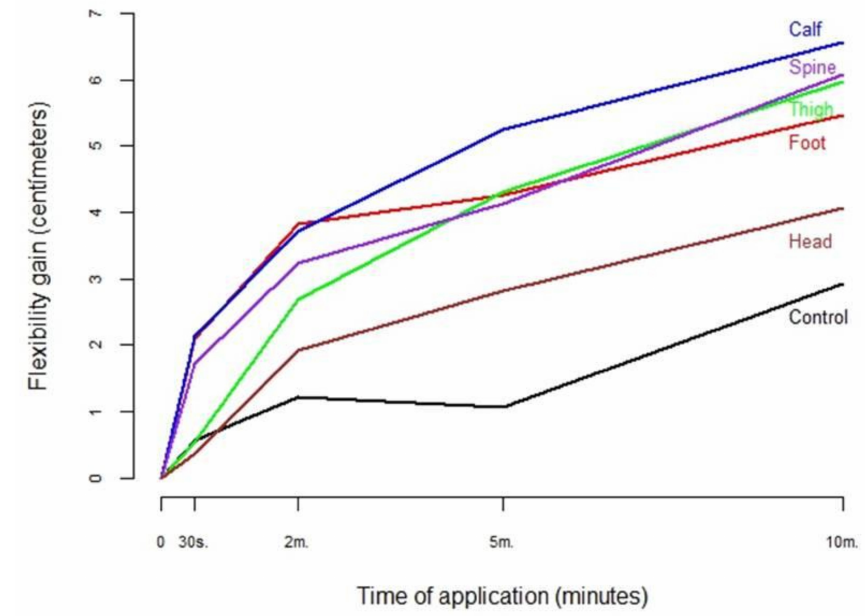
Figure 4. Hamstring flexibility gain (cm) according to